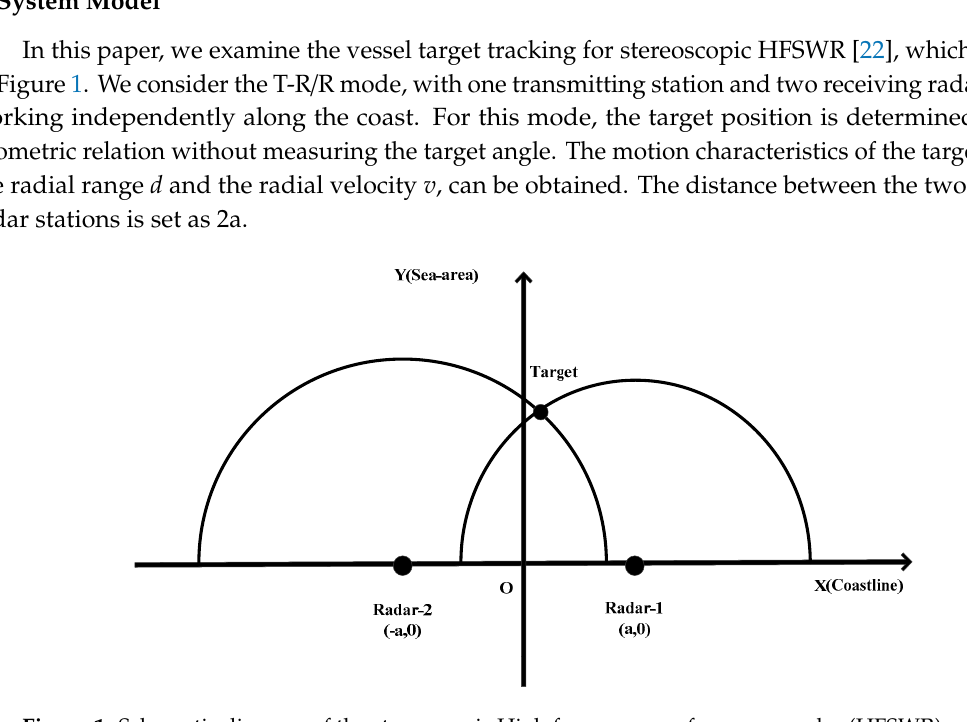
Figure 1. Schematic diagram of the stereoscopic High frequency surface wave radar (HFSWR) system.